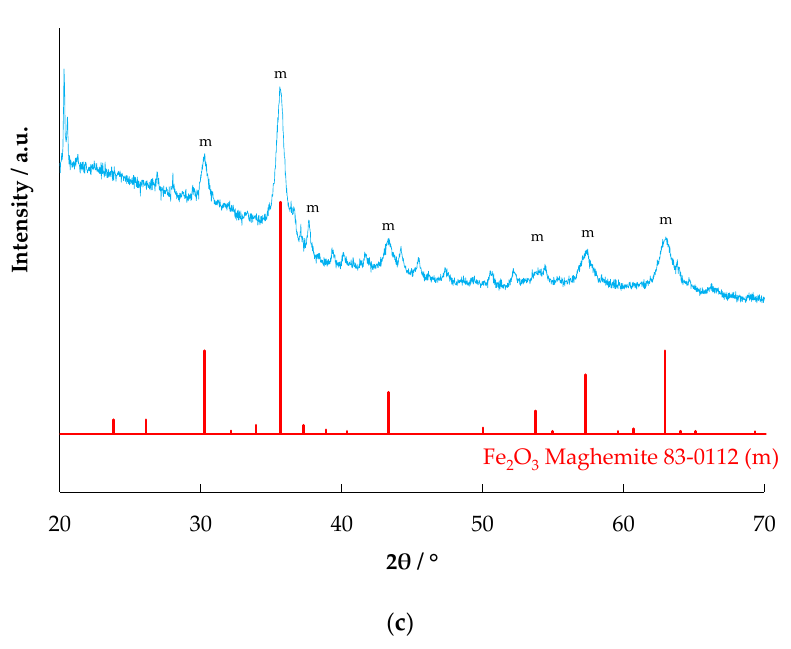
Catalysts 2021 , 11 , x FOR PEER REVIEW 7 of 21